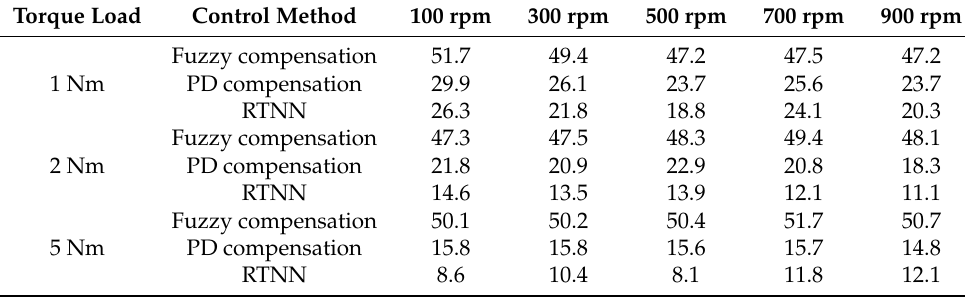
Table 1. Torque ripple comparison of the three methods